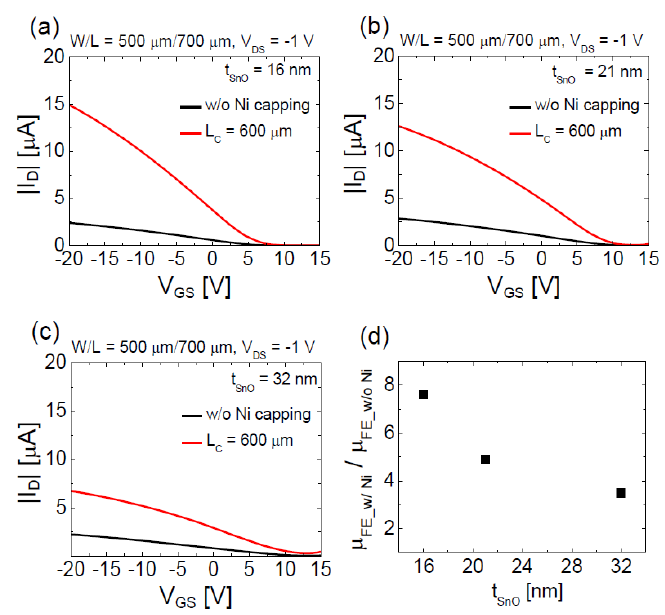
Figure 6. Linear-scale transfer characteristics of p-channel SnO TFTs with and without floating Ni capping layer ( L C = 600 μ m) measured from the devices having different channel thicknesses of: ( a ) 16 nm; ( b ) 21 nm; and ( c ) 32 nm. ( d ) Ratios of the μ FE extracted from the SnO TFT with the floating Ni capping layer ( L C = 600 μ m) to that extracted from the SnO TFT without the capping layer in every TFT with different channel thicknesses of 16, 21, and 32 nm. Here, μ FE_w/ Ni and μ FE_w/o Ni represent μ FE extracted from SnO TFT with and without floating Ni capping layer, respectively.